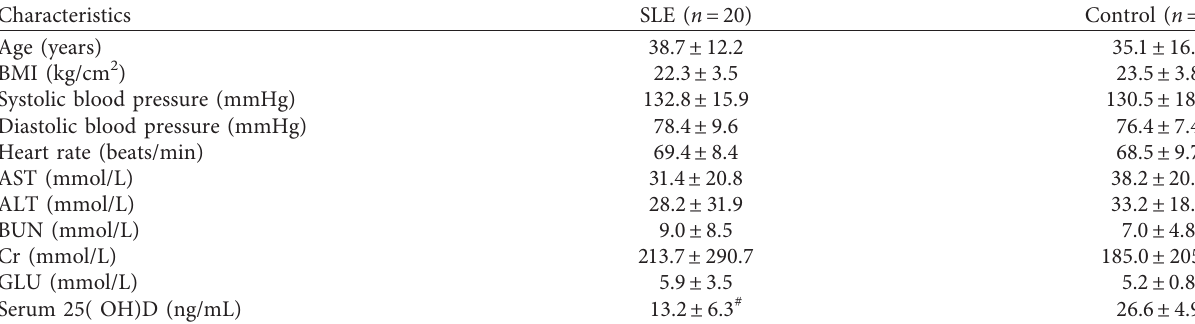
Table 1: General clinical